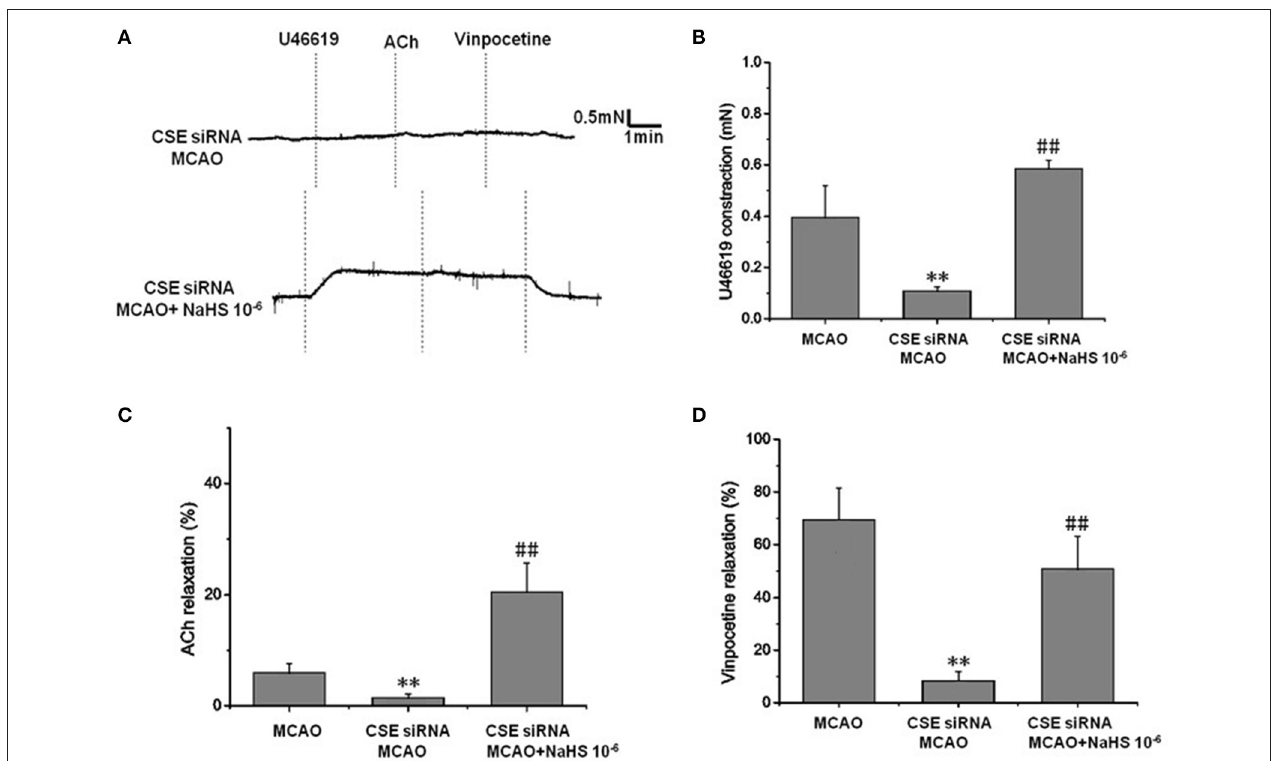
FIGURE 2 | Effect of endogenous H 2 S on cerebrovascular dysfunction injured by cerebral I/R (mean ± SD, n = 8). (A) Original tracings of U46619-, ACh-, vinpocetine-, and NaHS-induced responses of MCA derived from CSE knocked down rats after MCAO. (B) The effect of CSE knockdown and NaHS on U46619-meditated contraction. (C) The effect of CSE knockdown on and NaHS- or ACh-meditated relaxation. (D) The effect of CSE knockdown and NaHS on vinpocetine-meditated relaxation. ** P < 0.01 vs. sham, ## P < 0.01 vs.